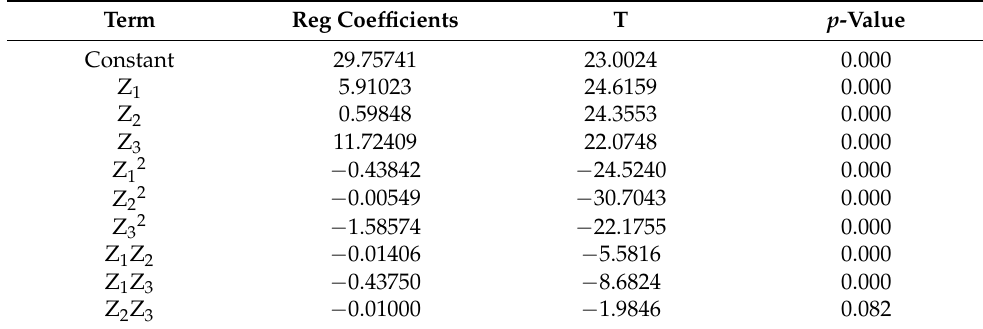
Table 8. Regression coefficients for the CEC central composite